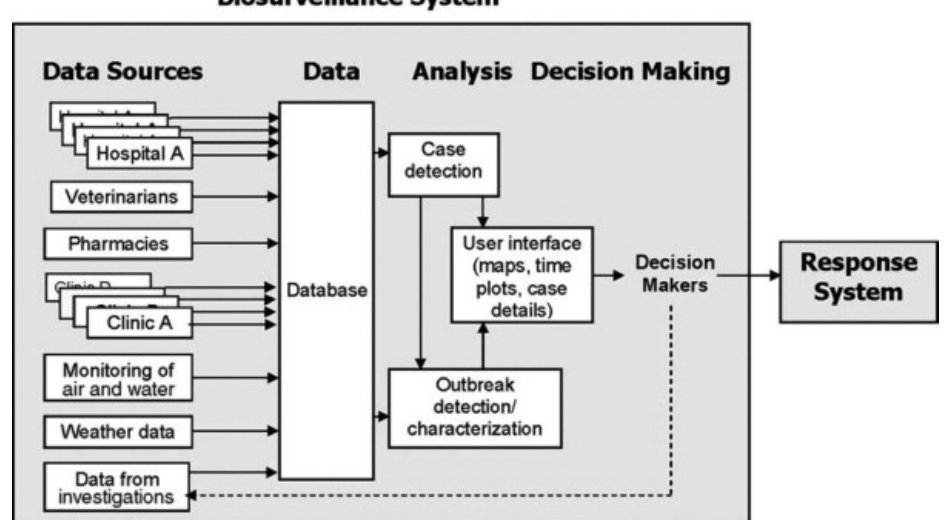
Figure 1. Diagram of biosurveillance system by Wagner [7] .